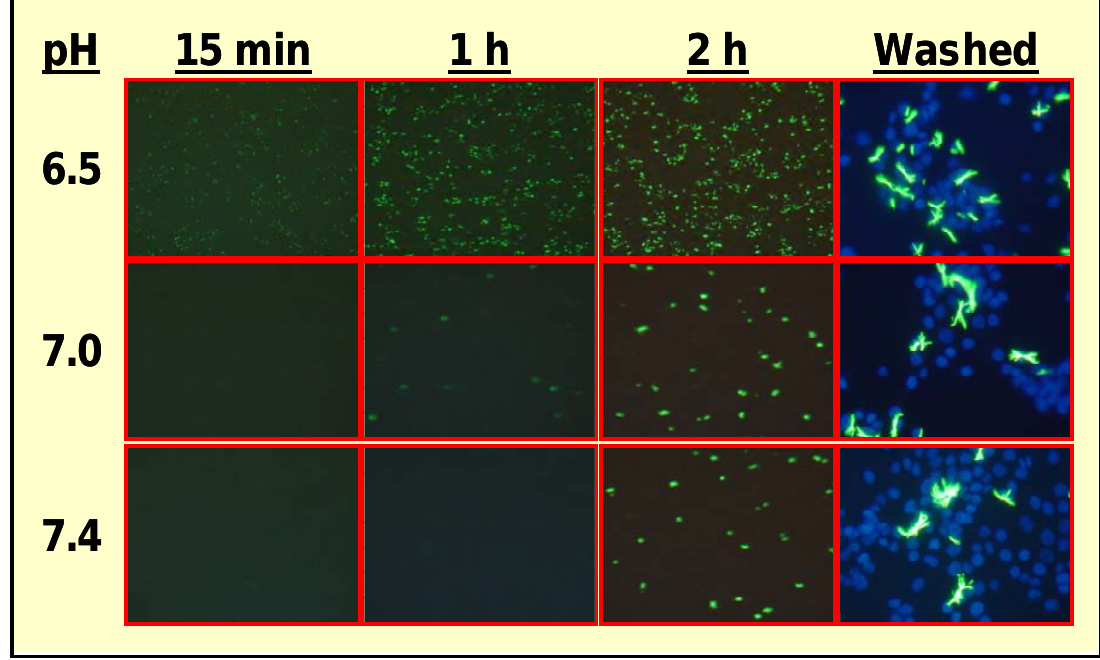
Figure 6. Fluorescence microscopy of viable human T3M4 pancreatic tumor cells incubated (37 o C) in vitro with IQ in media at varying pH, showing that prodrug is 2–P hydrolyzed more efficiently and more rapidly at pH 6.5. Columns 1–3: low power – cells not washed; column 4: high power – cells washed with PBS, fixed in methanol, and nuclei counterstained with